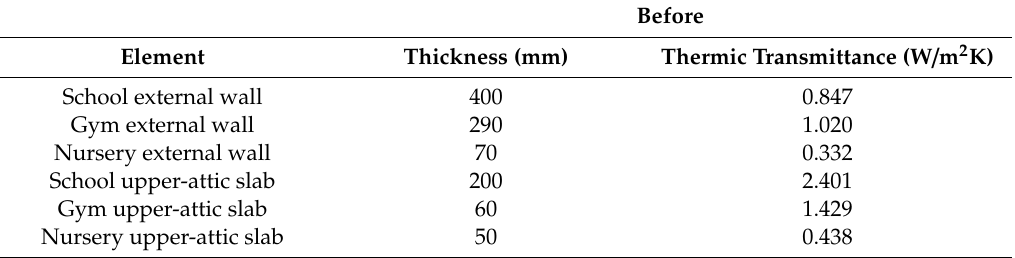
Table 3. Oulx envelope system characteristics (before retrofitting).